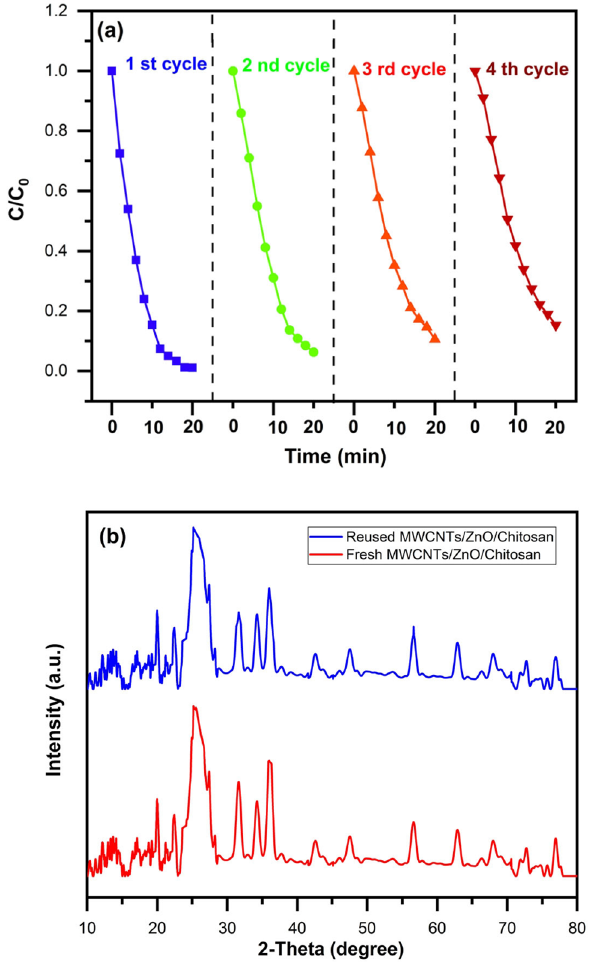
Figure 14. The test of stability of MWCNTs/ZnO/Chitosan: ( a ) recycling experiments of MWCNTs/ZnO/ Chitosan for the photocatalytic degradation of MB. ( b ) XRD patterns of MWCNTs/ZnO/Chitosan before and after four consecutive recycling photocatalysis.